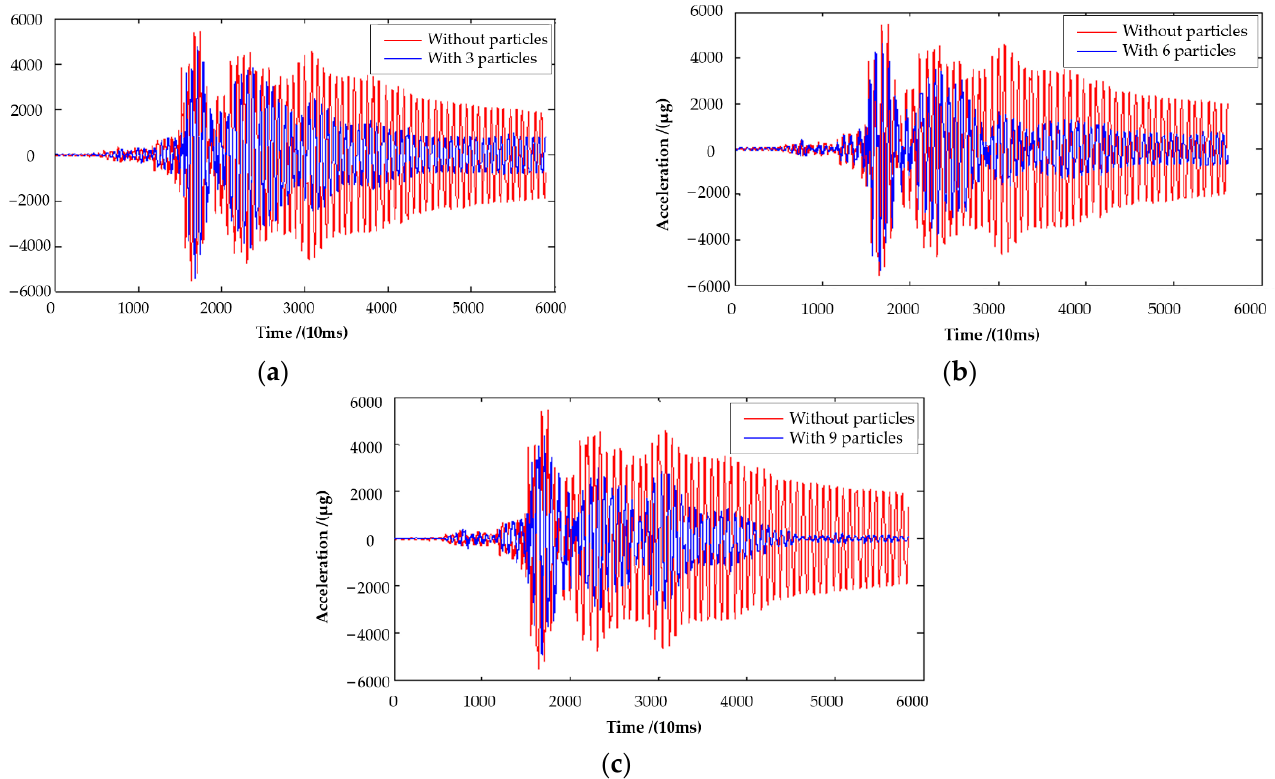
Figure 7. Acceleration responses of 3% mass ratio under Kobe wave: ( a ) the particle number is 3; ( b ) the particle number is 6; ( c ) the particle number is 9.